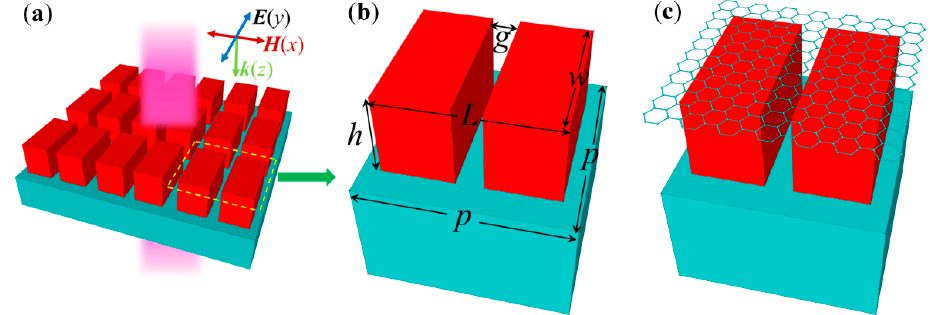
Figure 1. ( a ) Schematic of the all-dielectric metasurface. Diagrams of the unit cell for ( b ) the all-dielectric metasurface and ( c ) the graphene-loaded all-dielectric metasurface.